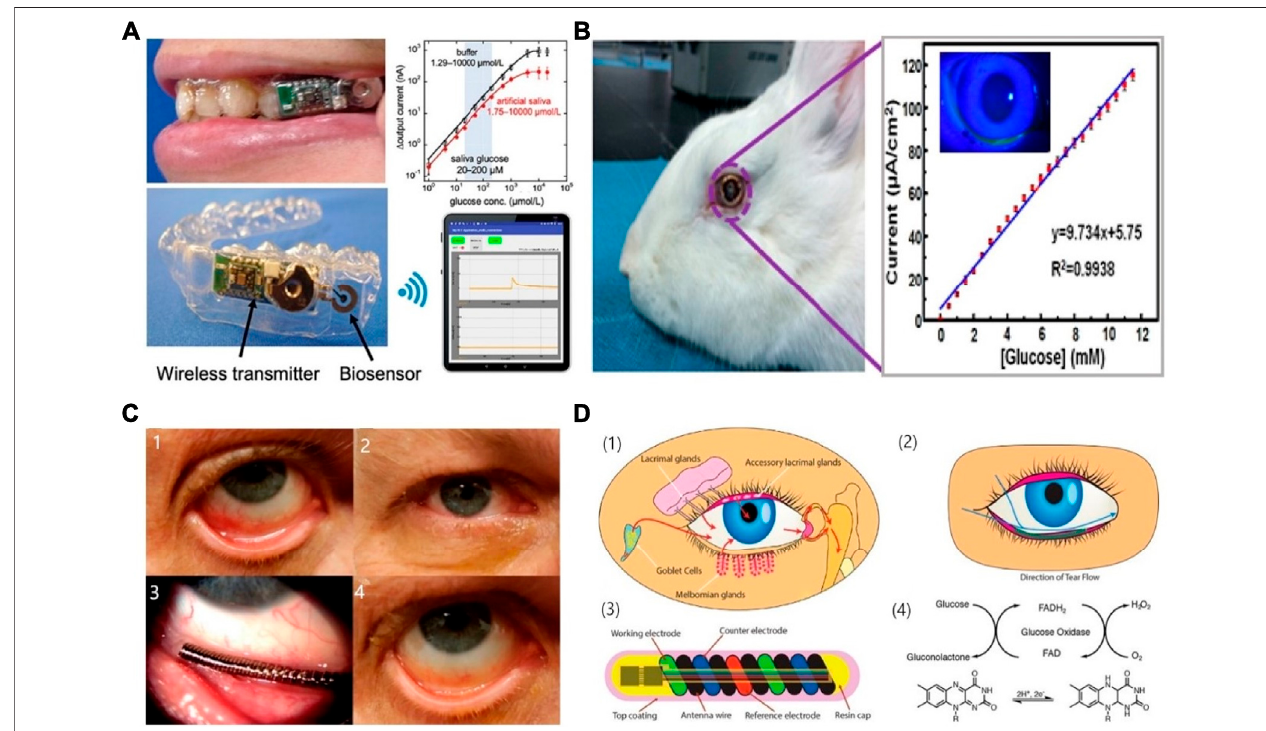
FIGURE 3 | Saliva & tear fl uid-based CGMs. (A) Mouthguard glucose sensor: structure, calibration curve and android app (Arakawa et al., 2020). (B) Eyeglasses glucose sensor was used in rabbit experiment and the calibration curve (Zou et al., 2019). (C) Eye implantable CGMs impacted on eyes. A: Baseline evaluation. The eye sufferedmechanicalrubbingandredness.B – D:Before/middle/afterthetrial,theeyedidnotshowrednessordamage(Kownackaetal.,2018). (D) Schematicillustration and properties ofthe CGMs. (1), (2) the tear fl uid entered the device. (3) the structure of the tear glucose device. (4) Mechanism the glucose detection. Reaction for the GOD and glucose (Kownacka et al., 2018)